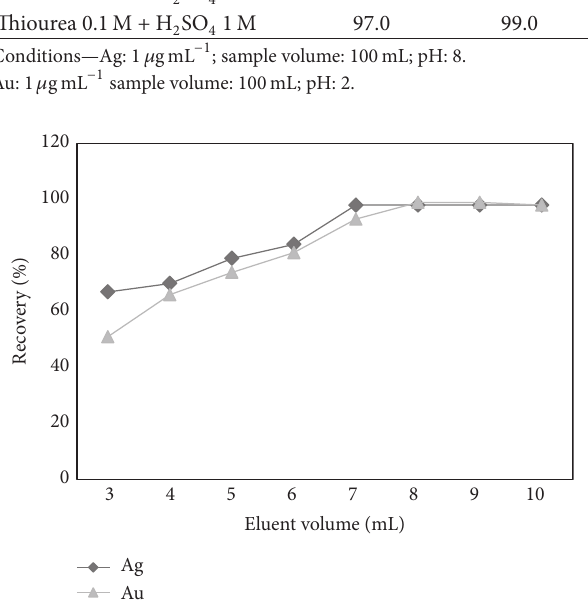
F 5: Effect of eluent volume on the percent recovery of Ag(I) and Au(III) by